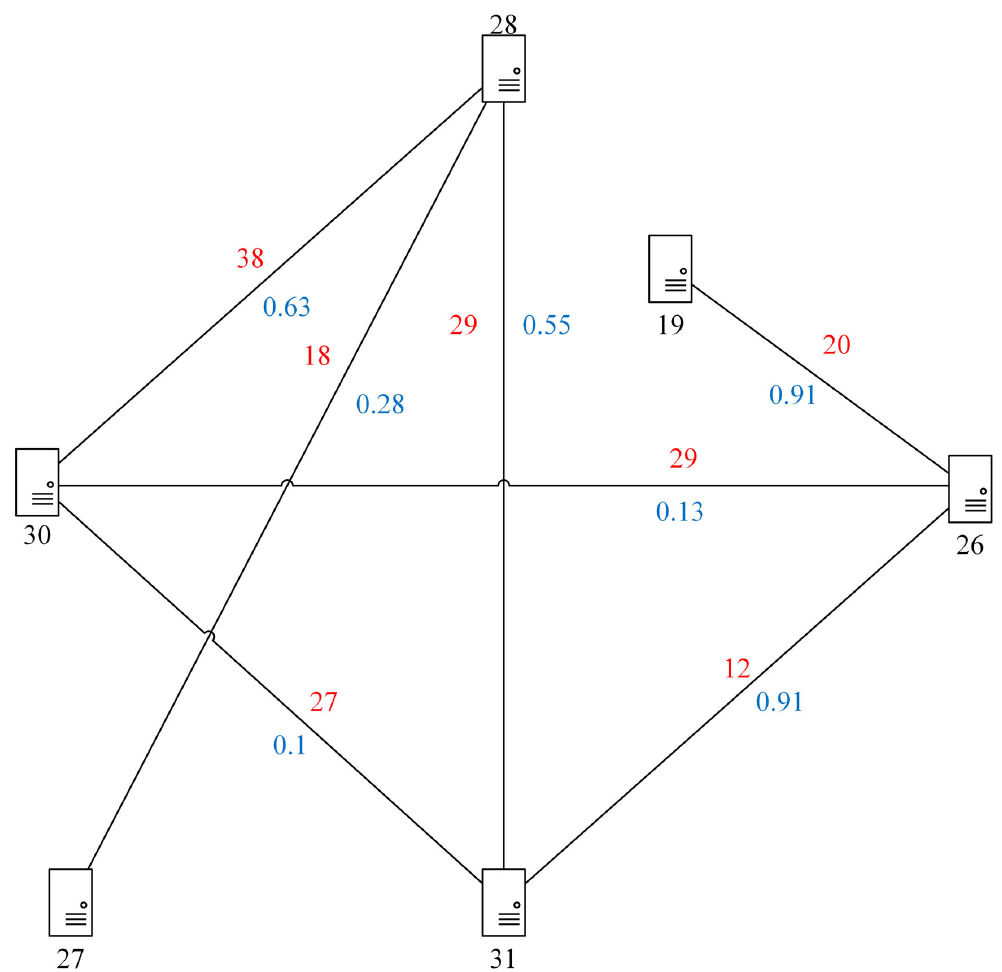
Figure 1. Network topology with CPU capacity, bandwidth capacity, and link delay.